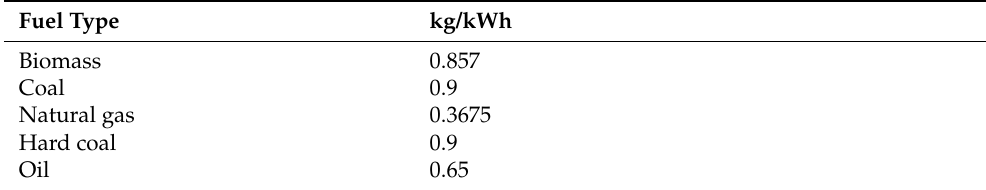
Table A1. CO 2 emissions for different fuels used in electricity generation ( β